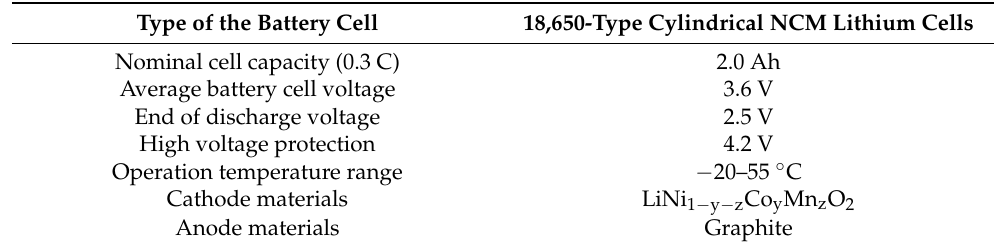
Table 1. List of main parameters of the